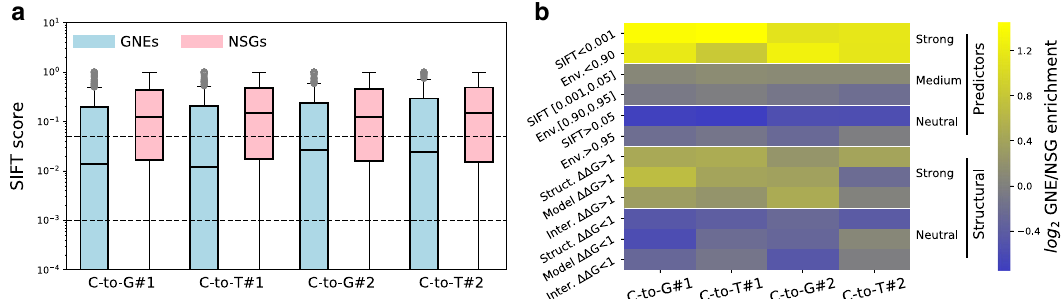
Fig. 4 GNE induced mutations are enriched in predicted deleterious effects. a SIFT score distributions for the most likely induced mutations of both GNEs (blue) and NSGs (red). The thresholds for the categories used in the enrichment calculations in b are shown as black dotted lines. SIFT scores represent the probability of a speci fi c mutation being tolerated based on evolutionary information: the fi rst threshold of 0.05 was set by the authors in the original manuscript 32 but might be permissive considering the number of mutations tested in our experiment ( n = 571, 12,718, 457, 8767, 430, 7609, 343, 5847). All GNE vs NSG score comparisons are signi fi cant (Welch ’ s t -test p -values: 1.64 × 10 − 21 , 5.99 × 10 − 20 , 1.62 × 10 − 12 , 1.75 × 10 − 9 ). Boxplots represent the upper and lower quartiles of the data, with the median shown as a black bar. Whiskers extend to 1.5 times the interquartile range (Q3 – Q1) at most. Outliers are shown in gray. The box cutoff is due to the large fraction of mutations for which the SIFT score is 0. b Enrichment folds of GNEs over NSGs for different variant effect prediction measurements. Envision score (Env.), SIFT score (SIFT), protein folding stability based on solved protein structures (Struct. ΔΔ G), protein folding based on homology models (Model ΔΔ G) and protein – protein interaction interface stability based on structure data (Inter. ΔΔ G). The predictions based on conservation and experimental data are grouped under ‘ Predictors ’ and those based on the computational analysis of protein structures and complexes under ‘ Structural ’ . Source data are available in the Source Data fi